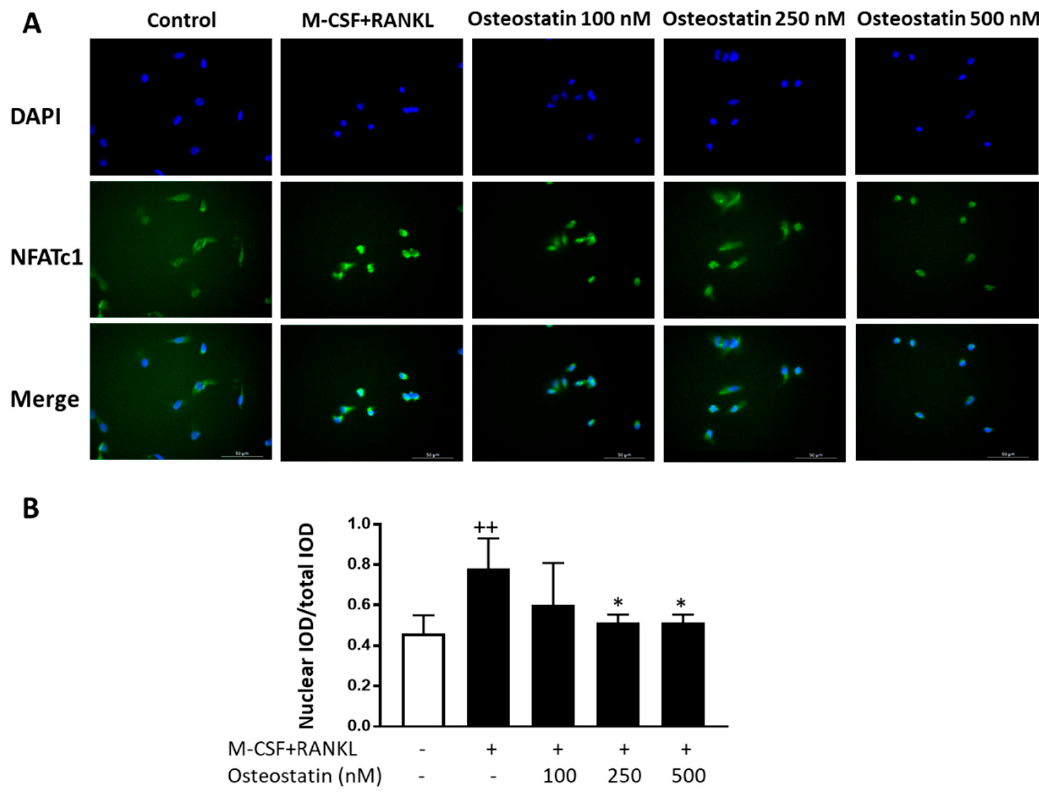
Figure 4. The effects of osteostatin on NFATc1 nuclear translocation. Osteoclast precursors were stimulated with M-CSF and RANKL in the presence or absence of osteostatin (final concentrations: 100, 250 and 500 nM) for 2 days, and then NFATc1 nuclear translocation was examined by immunofluorescence. ( A ) Representative images; Bar = 50 µ m. Nuclei were stained by DAPI. ( B ) The nuclear/total integrated optical density (IOD) ratio was obtained to compare NFATc1 nuclear translocation. Results are expressed as the mean ± S.D. of three independent experiments; ++ p < 0.01 vs. control; * p < 0.05 vs. M-CSF+RANKL.